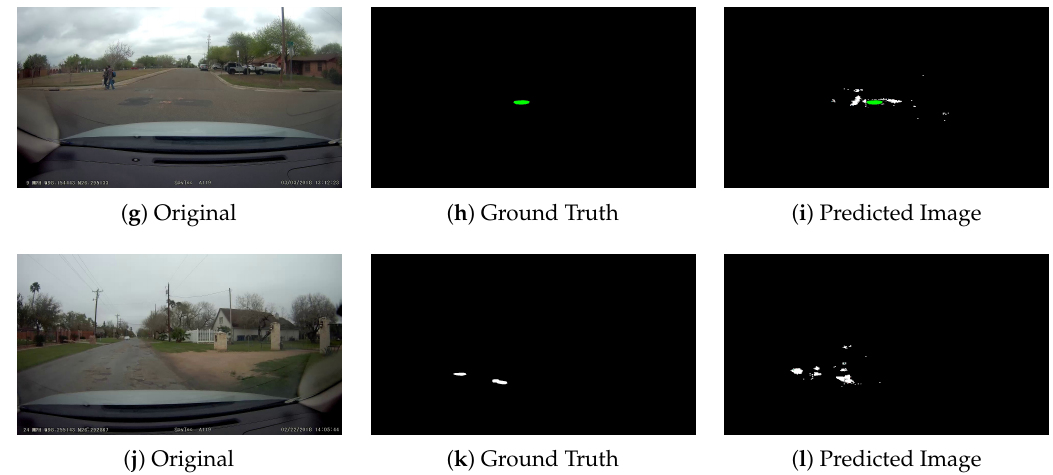
Figure 11. Semantic segmentation examples with four classes using FC-DenseNet 130